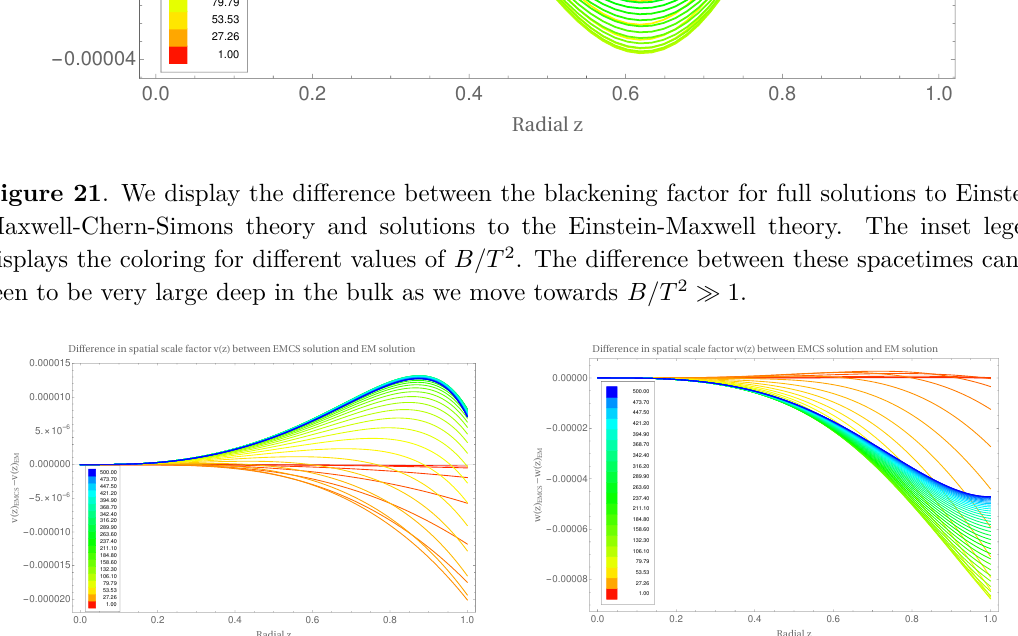
Figure 22 . We display the difference between the spatial scale factors v ( z ) and w ( z ) for full solu- tions to Einstein-Maxwell-Chern-Simons theory and those for Einstein-Maxwell theory. The inset legend displays the coloring for different values of B/T 2 . The difference between these spacetimes can be seen to be very large deep in the bulk as we move towards B/T 2 (cid:29) 1